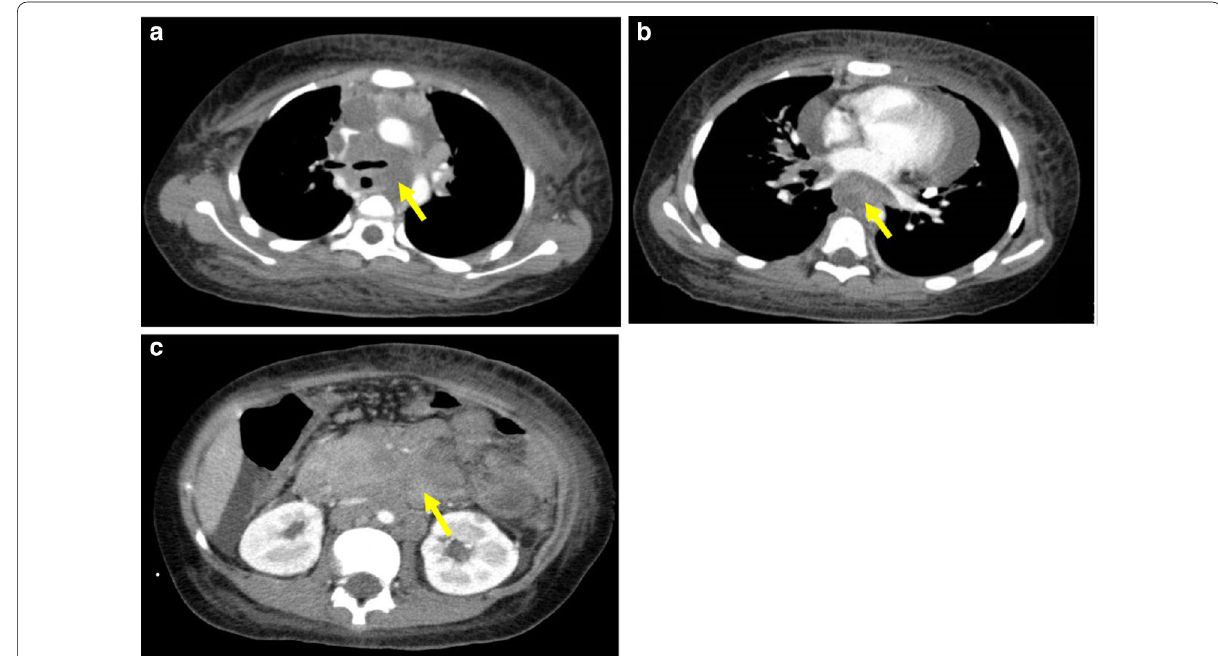
Fig. 1 Contrast-enhanced computed tomography (CT) at admission. a Chest CT revealing mediastinal lymphadenopathy along with compression of the left and right bronchi (yellow arrow). b Chest CT revealing mediastinal lymphadenopathy along with compression of the esophagus (yellow arrow). c Abdominal CT revealing lymphadenopathy of the para-aorta, pancreas, and mesentery (yellow